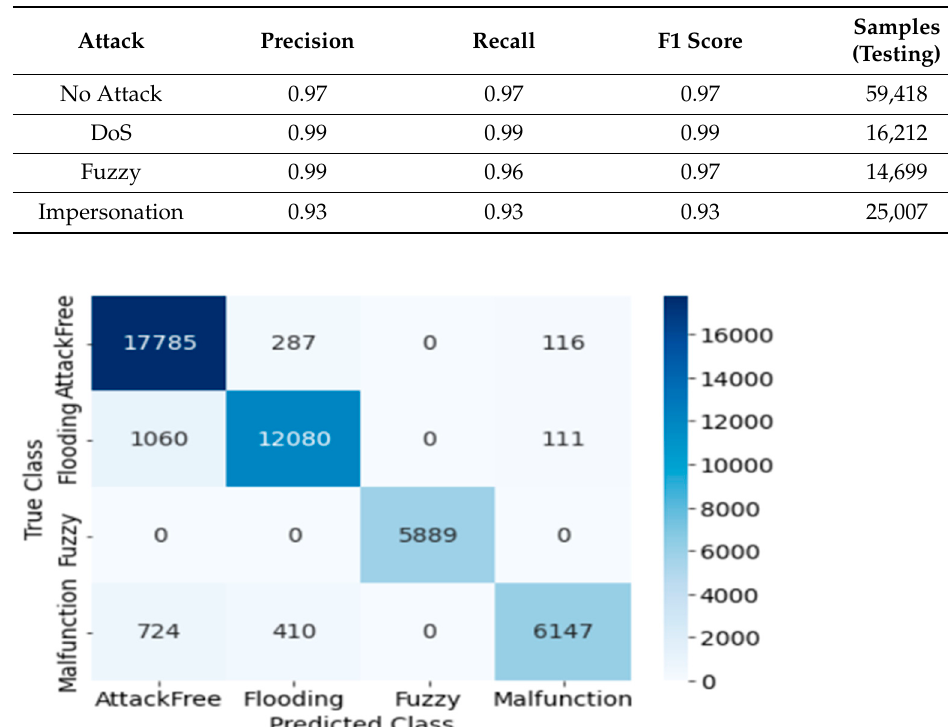
Table 5. Detection performance of DoS, fuzzy, impersonation, and attack-free for KNN (Dataset 1).